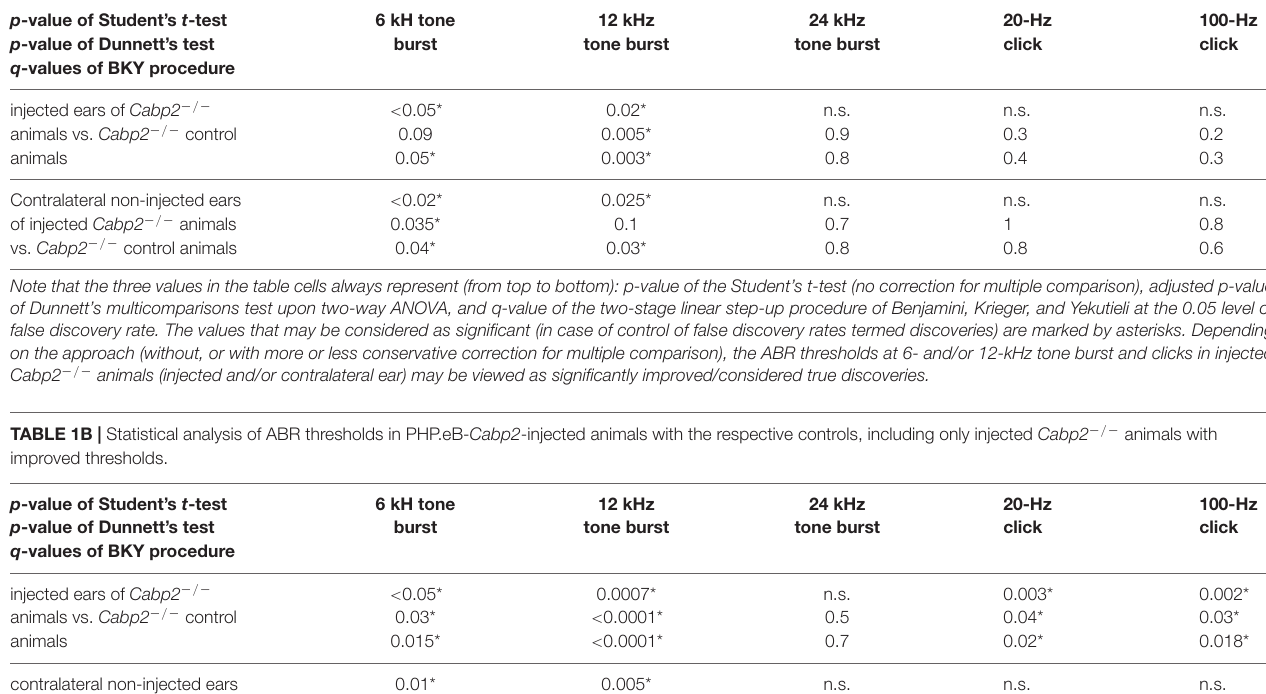
TABLE 1A | Statistical analysis of ABR thresholds in animals injected with the PHP.eB-calcium-binding protein 2 ( Cabp2 ) with the respective controls, including all injected Cabp2 − / − animals. p -value of Student’s t -test p -value of Dunnett’s